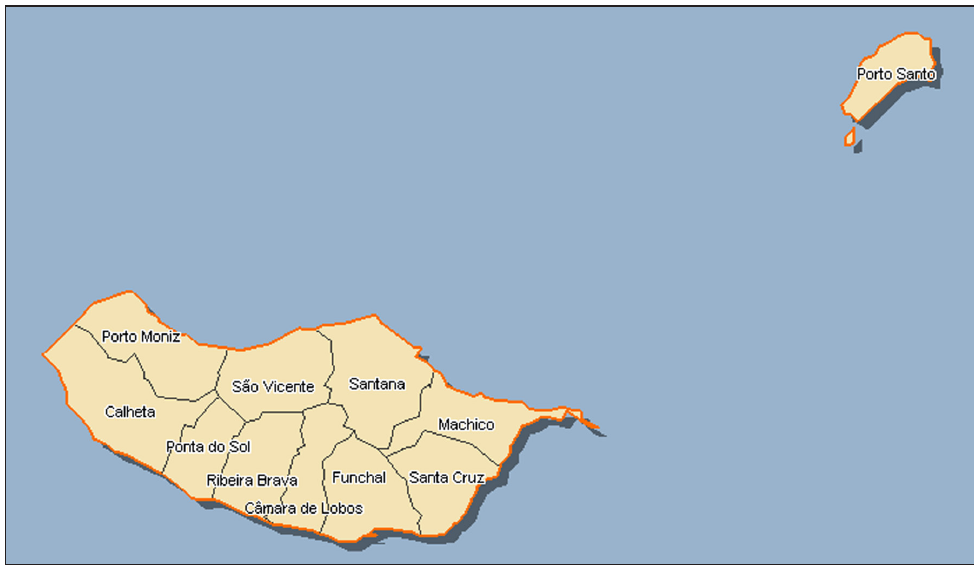
Figure 1: Madeira and Porto Santo Islands